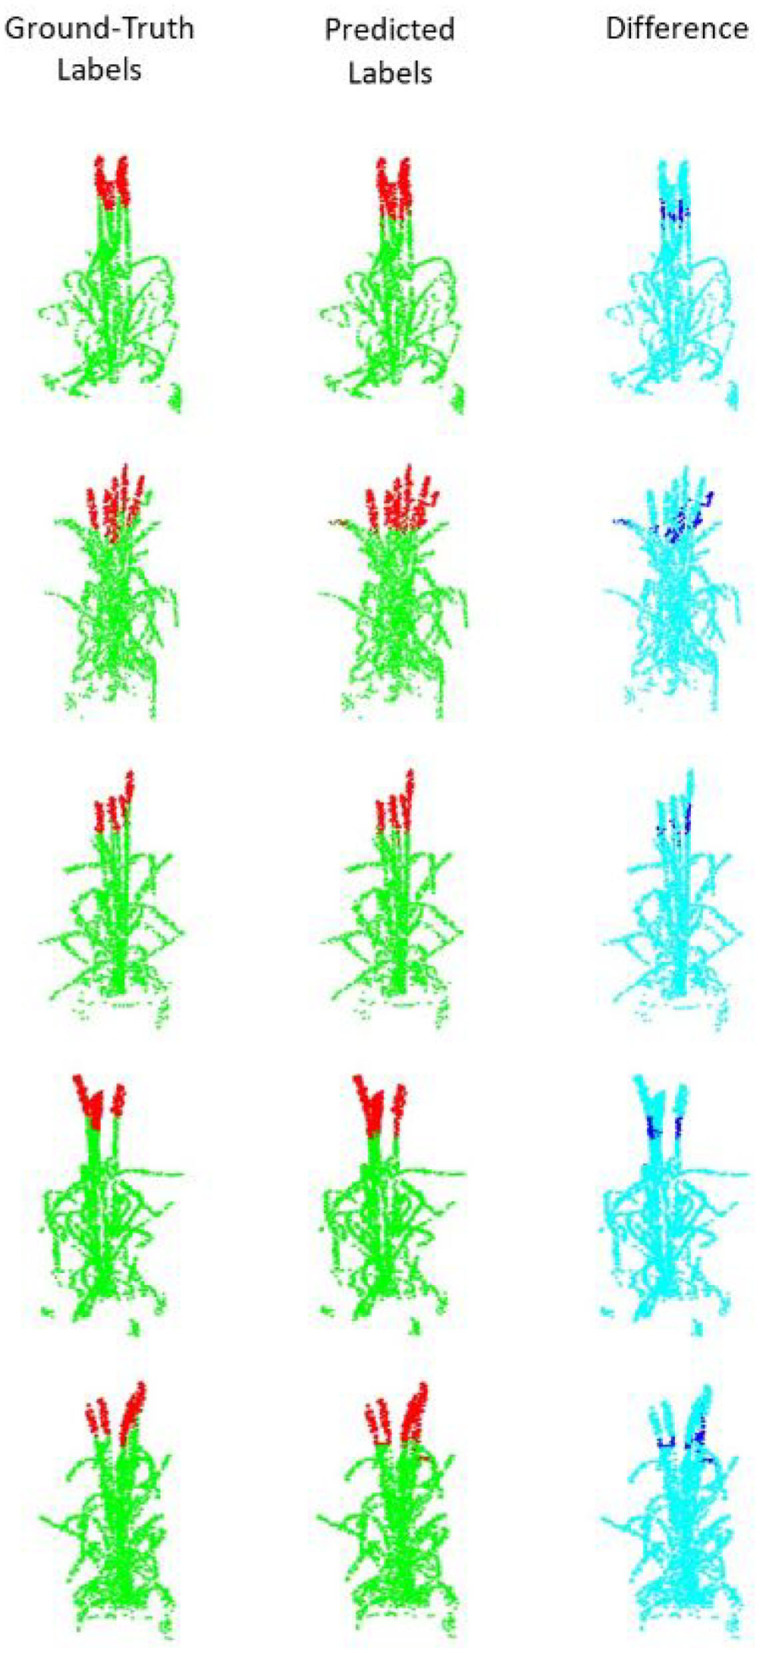
Segmentation results for point clouds containing 2,048 points. (Left) The ground truth samples (ears are shown in red and non-ears in green) annotated in MeshLab; (middle) The predicted/segmented labels; (Right) The difference between the ground truth and the segmented results is shown in dark blue.